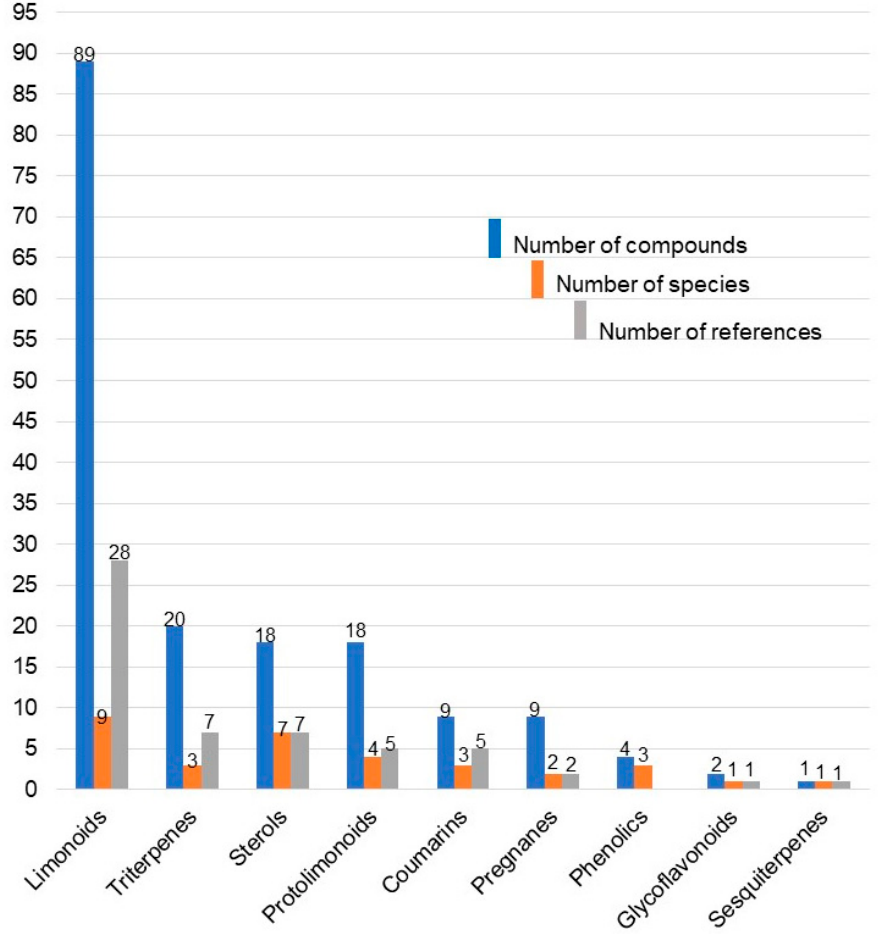
Figure 4. Number of compounds (chemical diversity), classes of compounds, and references for each species of South African Meliaceae.